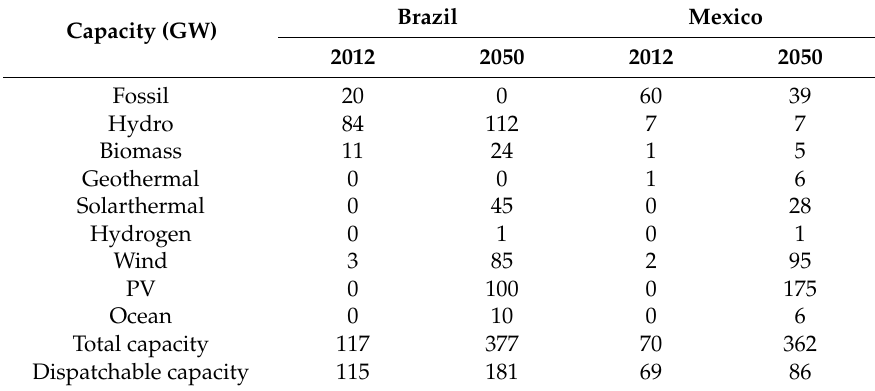
Table 8. Installed capacity by technology and dispatchable capacity in E [R] for 2012 and 2050. Brazil Capacity (GW)